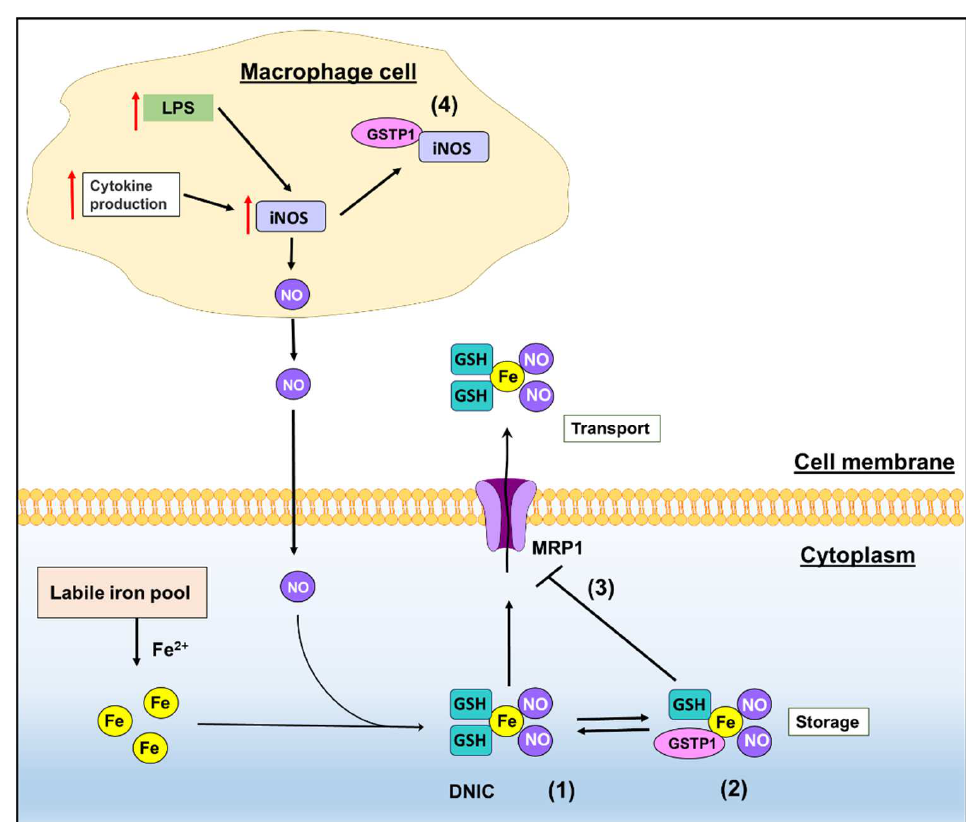
Figure 1. Schematic of the functions of GSTP1 in NO metabolism where: (1) NO binds to iron and GSH to generate small molecular weight dinitrosyl-dithiol iron complexes (DNICs); (2) DNICs then bind to GSTP1 to lead to a store of NO; (3) the binding of DNICs by GSTP1 prevents their transport out of the cell by MRP1; and (4) GSTP1 can also bind to inducible nitric oxide synthase (iNOS) that generates intracellular NO.